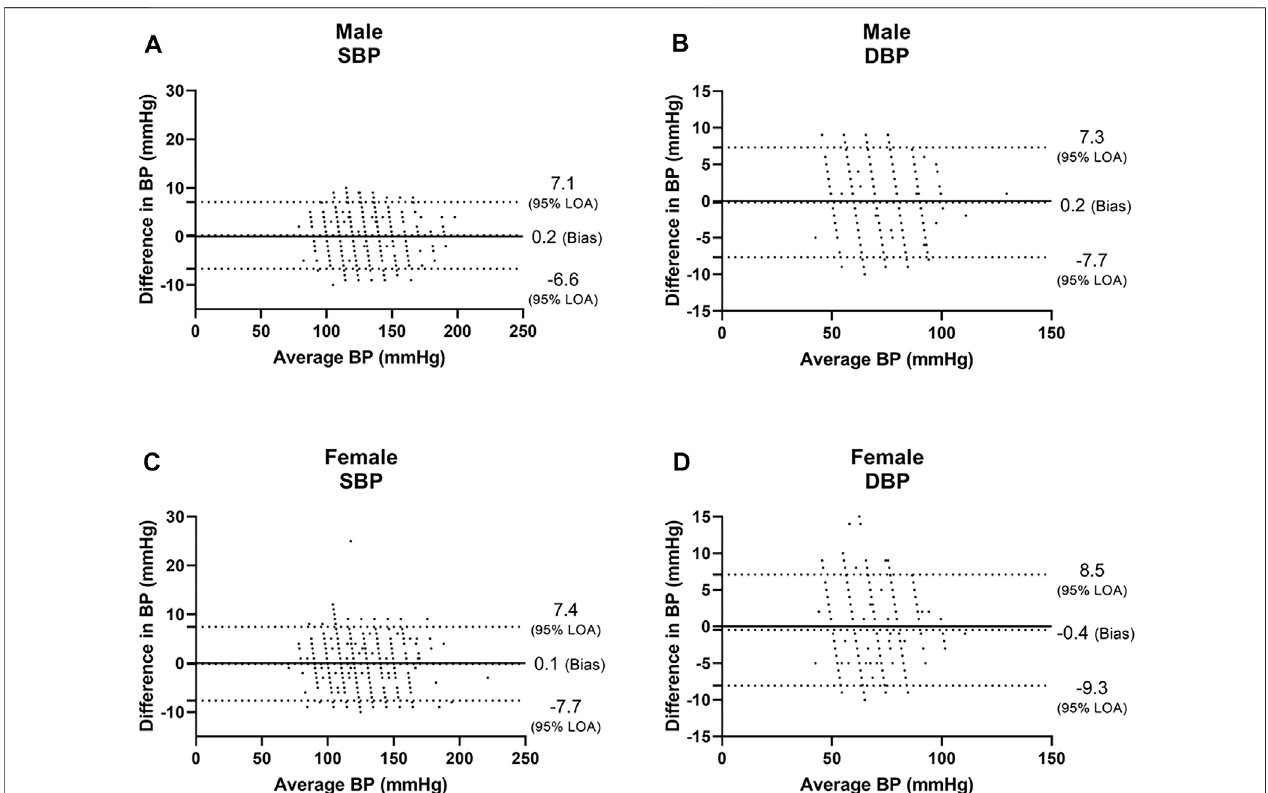
FIGURE 1 | Bland-Altman analysis of males and females. SBP systolic blood pressure, DBP diastolic blood pressure.